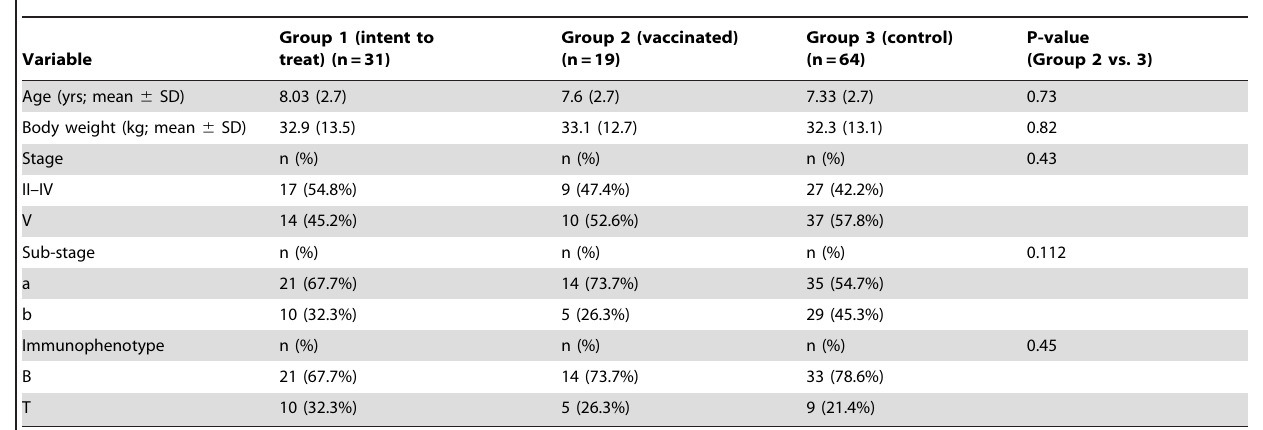
Table 1. Canine patient